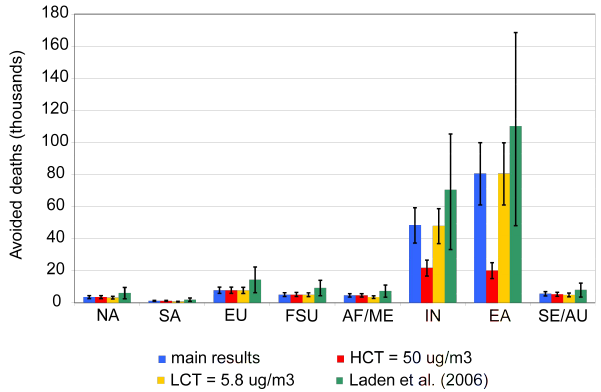
Fig. 9. Sensitivity of estimated avoided annual premature car- diopulmonary and lung cancer deaths from halving global anthro- pogenic BC emissions to a high concentration threshold (HCT) of 50µgm − 3 , a low-concentration threshold (LCT) of 30µgm − 3 , and relative risk estimates from Laden et al. (2006; cardiovascular and lung cancer mortality only). Confidence intervals (95%) reflect un- certainty in the CRF